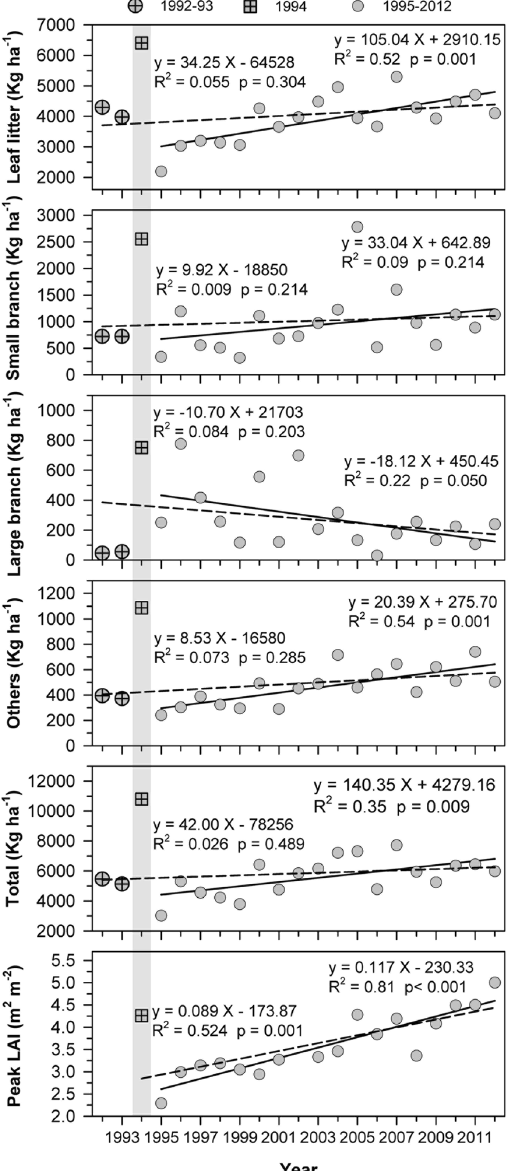
Figure 5. The patterns of annual litterfall and annual peak leaf area index (LAI) at Fushan Experimental Forest. Dash line includes the entire 21-yr data set and the solid includes only data following the 1994 typhoon season (gray area) in which three category 3 typhoon affected the